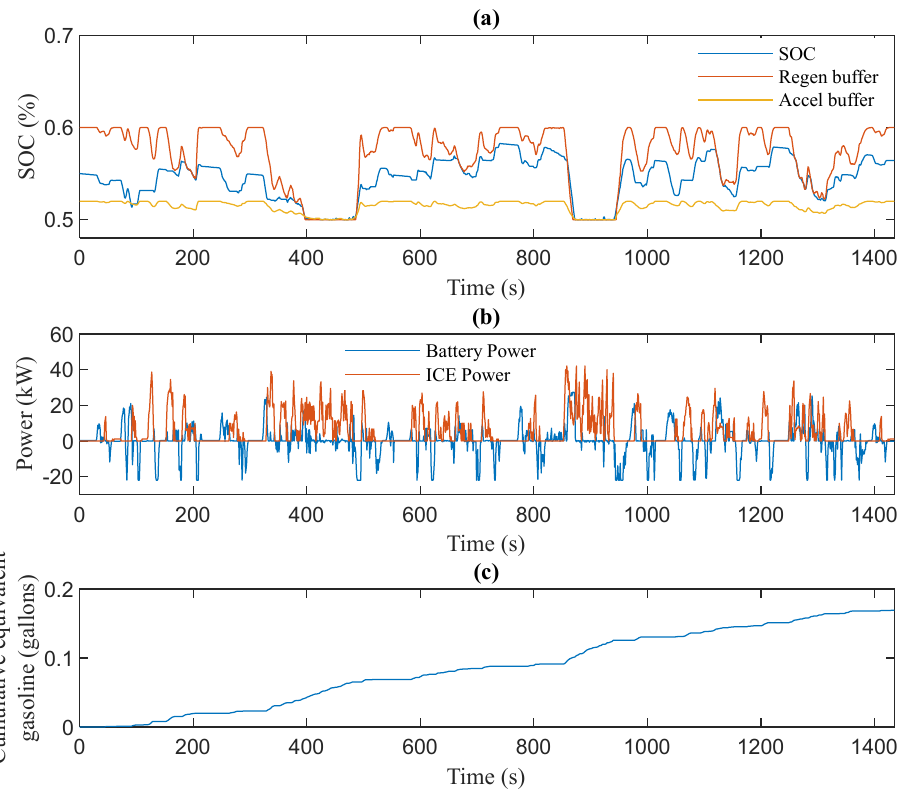
Figure 4. FASTsim simulation results for the HEV of [44] for LA92 cycle. ( a ) Battery SOC; ( b ) powers of the battery and the ICE; ( c ) cumulative equivalent gasoline consumption in gallons.